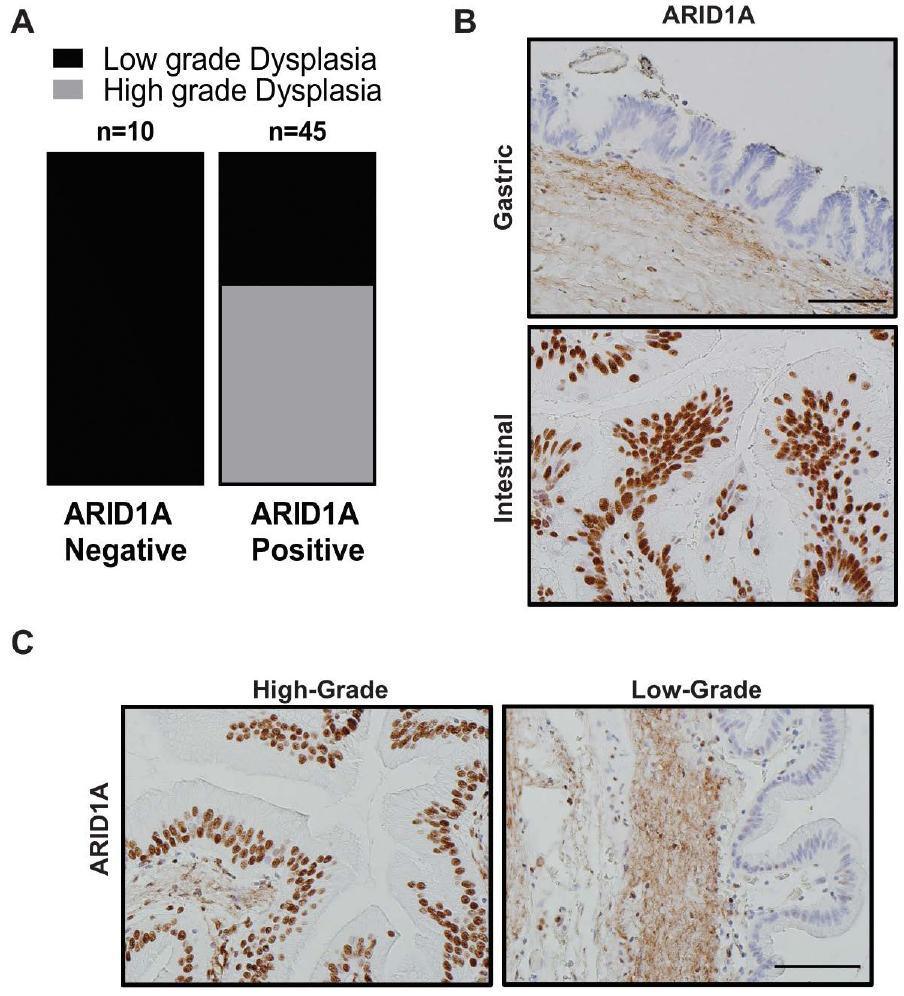
Figure 2. Loss of ARID1A expression among human IPMN is mostly restricted to low-grade gastric subtype IPMN. ( A ) Quantification of IHC staining for ARID1A on patient samples representing IPMNs of various subtypes and dysplasia grade revealed lost expression specifically in low-grade lesions of gastric subtype. ( B ) IHC staining for ARID1A in gastric versus intestinal subtype of human IPMN and in high-grade versus low-grade dysplasia in the same patient ( C ). Scale bar is 100 µ